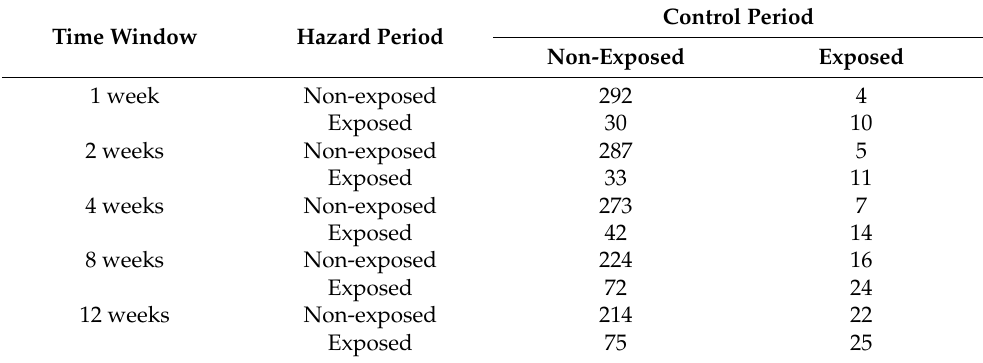
Table 2. Concordant and discordant pairs of purgative exposures observed among patients with new-onset atrial fibrillation between the hazard and control periods according to time windows. Time Window